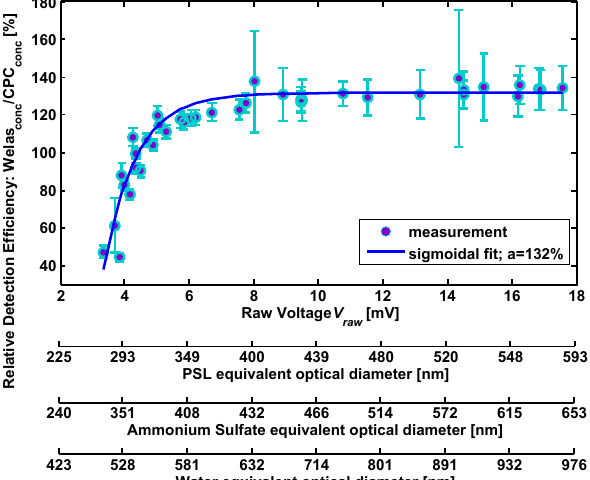
Figure 5. Counting efficiency for size-selected ammonium sulfate particles retrieved by dividing the WELAS number concentration measurement by the corresponding value measured by the CPC. The primary abscissa is the measured raw pulse height ( V raw ). The additional abscissa scales representing the PSL equivalent, ammo- nium sulfate and water equivalent optical diameters are calculated from V raw using the mean WELAS calibration value C V = 2 . 23. The value a depicts the plateau value of the sigmoidal fit.